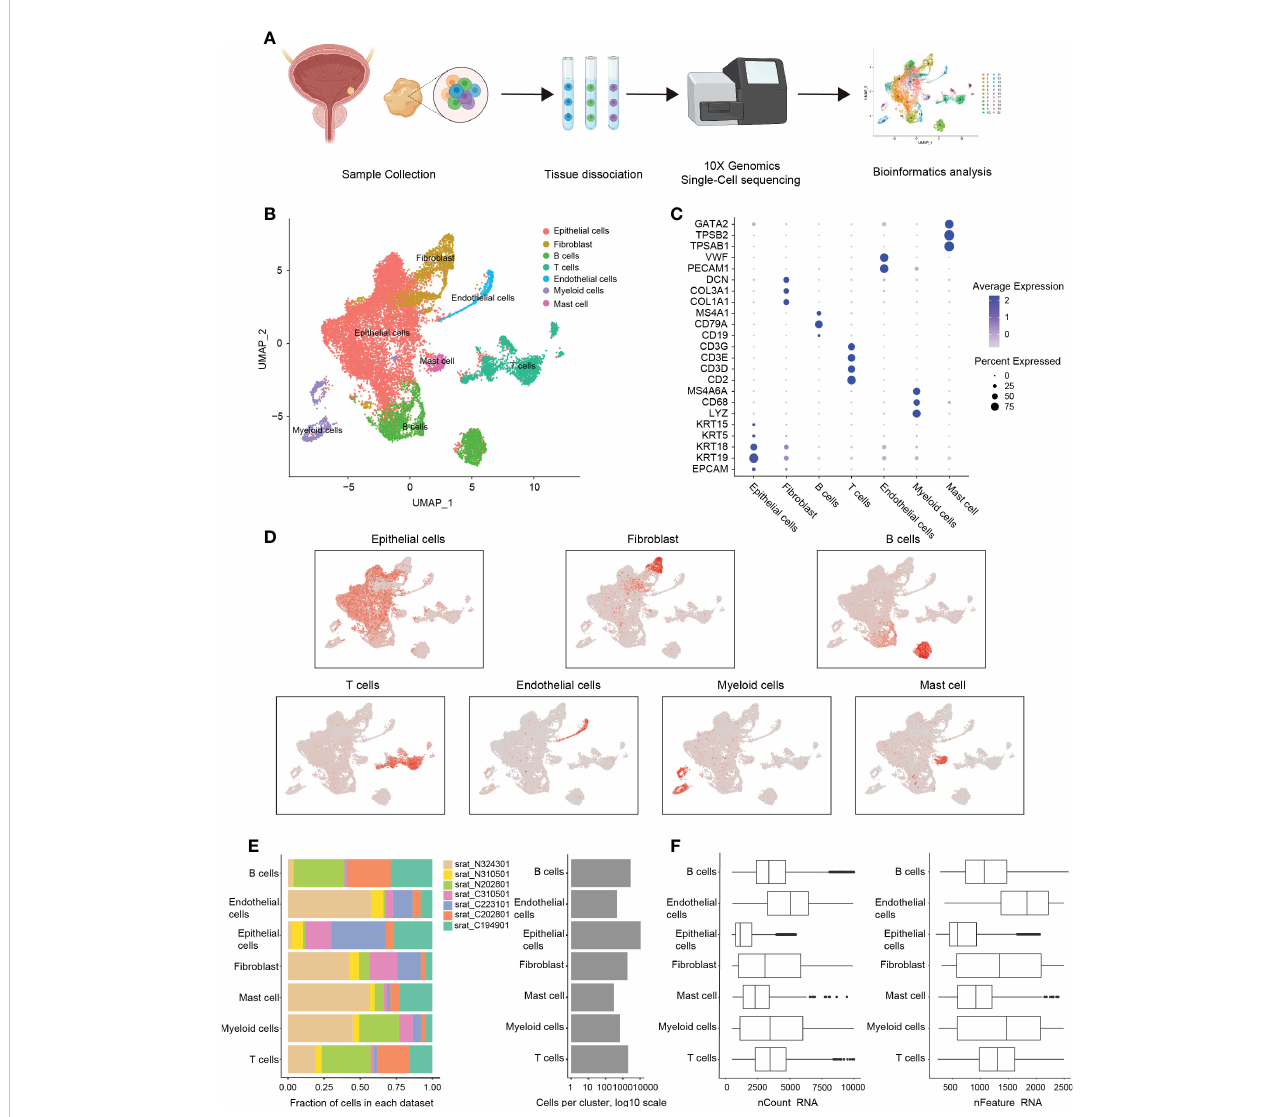
FIGURE 1 scRNA-sequencing analysis of the immune microenvironment in cystitis glandularis. (A) Work fl ow diagram of glandular cystitis sample collection and processing of scRNA-sequencing data. (B) Reduced dimension visualization U-MAP plot of scRNA-sequencing data obtained from all samples. Each color represents a cell type. (C) Dot plot of canonically expressed genes in each cell type after integration. (D) Distribution of canonically expression gene sets in each cell type present on the U-MAP plot. (E) Quantitative characteristics for each cell type. The samples starting with C are in fl ammatory tissues, and the samples starting with N are normal tissues. The number of cells per patient present in each cell type (left) and the total number of cells per cell type (right). (F) The detected gene expression value in each cell type (left) and featured number of genes